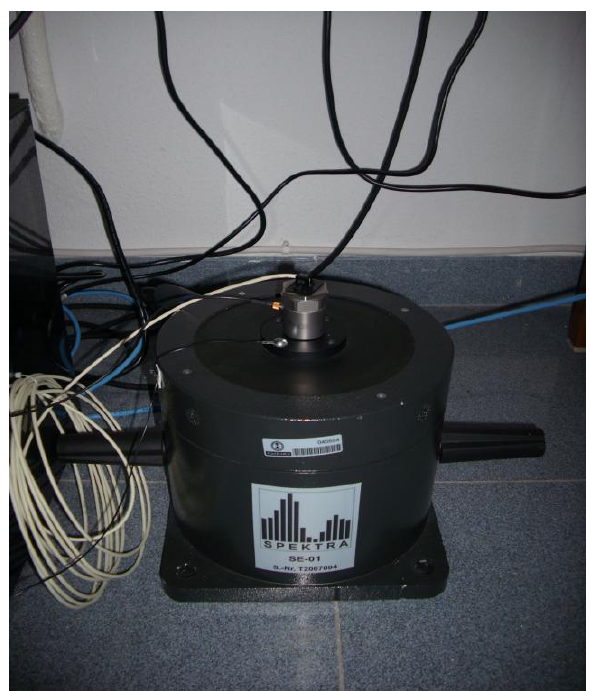
Figure 3. Vibration exciter SE-1.